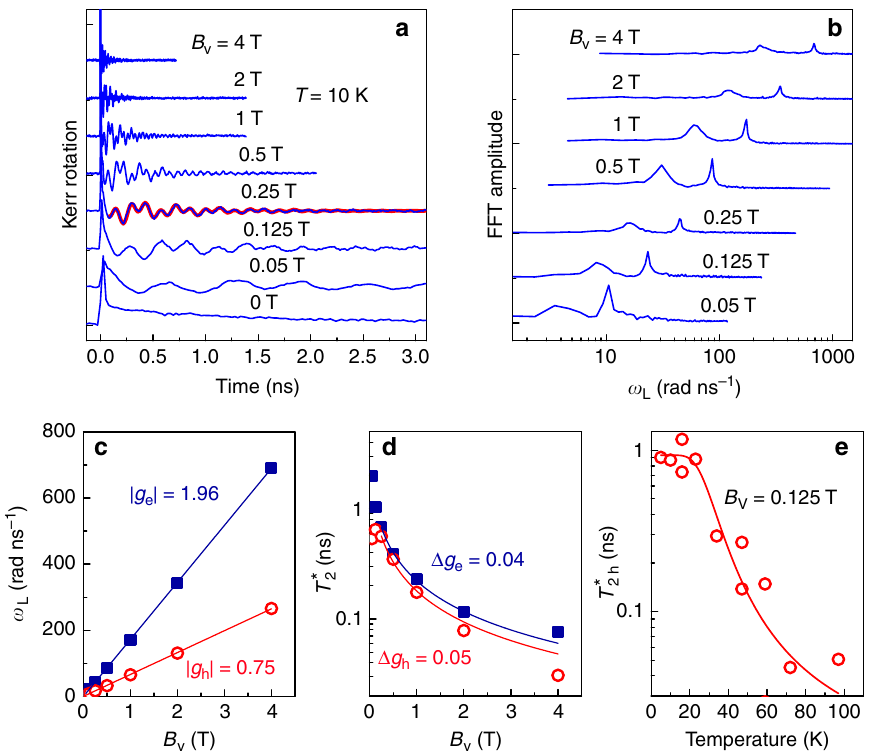
Fig. 2 Coherent spin dynamics in transverse magnetic fi eld. a Kerr rotation dynamics in CsPbBr 3 crystal at different magnetic fi elds. Magenta thick line for B V = 0.25 T is fi t to the experimental data with two decaying oscillatory functions (Methods). b Fast Fourier transform spectra of spin dynamics traces from a . c Magnetic fi eld dependencies of electron (squares) and hole (circles) Larmor frequencies. Lines show linear fi ts to data. d Magnetic fi eld dependencies of electron (squares) and hole (circles) spin dephasing times. Lines show reciprocal to B V fi ts to data with evaluated spread of g -factors. a – d T = 10 K. e Temperature dependence of hole spin dephasing time. Line is fi t with activation dependence having energy parameter Δ E = 14 meV. Source data are provided as a Source Data fi